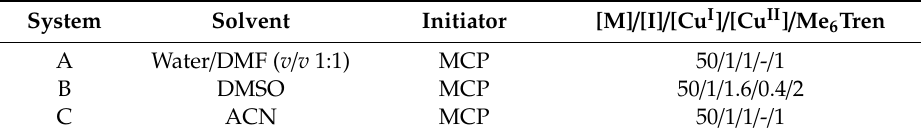
Table 1. Chosen atom transfer radical polymerization (ATRP) systems for end group